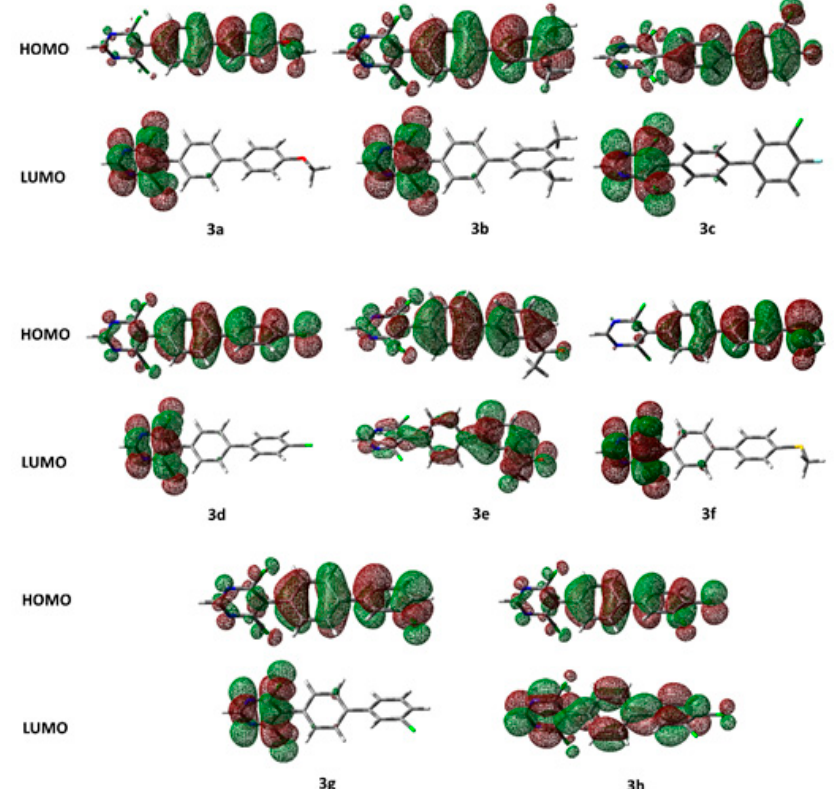
Figure 3. A presentation of the frontier orbitals of the molecules ( 3a–3h ) calculated at the PBE0- D3BJ/def2-TZVP/SMD water level of theory.